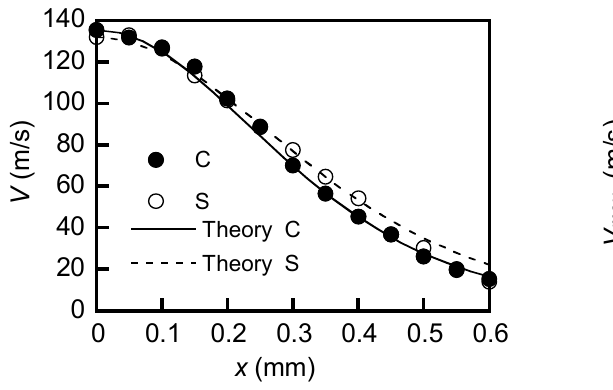
Fig. 6 Average jet velocity distribution in the tangential Fig. 7 Maximum velocity dependence on the pressure in the air storage tank for both types of